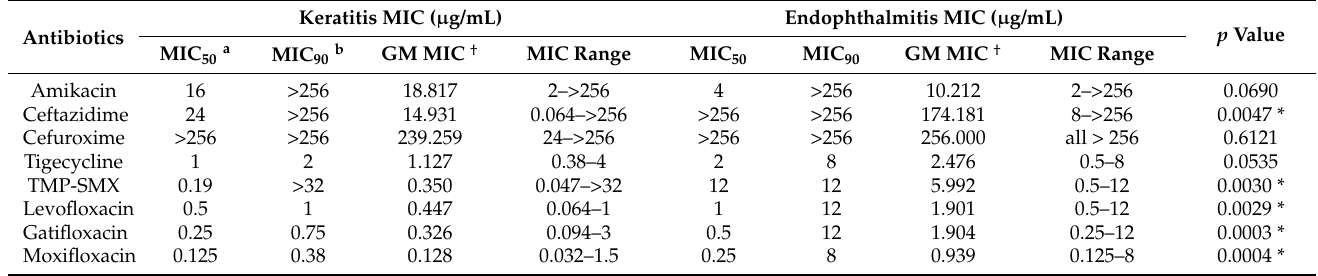
Table 2. Minimum Inhibitory Concentrations of S. maltophilia Isolates from Keratitis and Endoph- thalmitis.